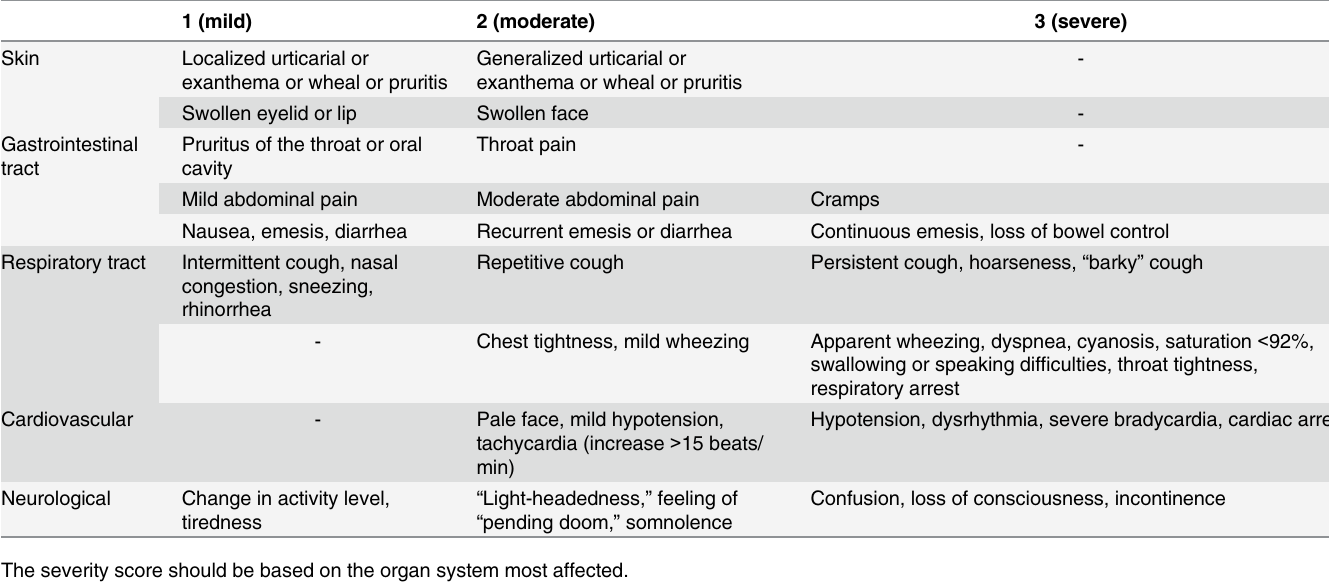
Table 1. Grading of